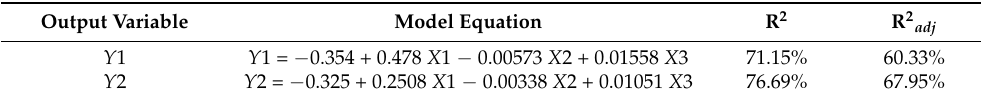
Table 2. Best hierarchical model from MINITAB© with just main effects for Y 2 (FD mean in µ m) and Y 1 (spread FD in µ m).